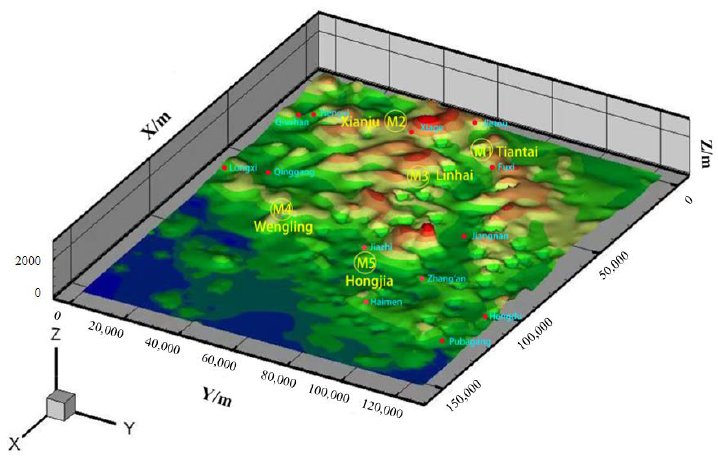
Figure 5. Computational domain of the CFD model (m).